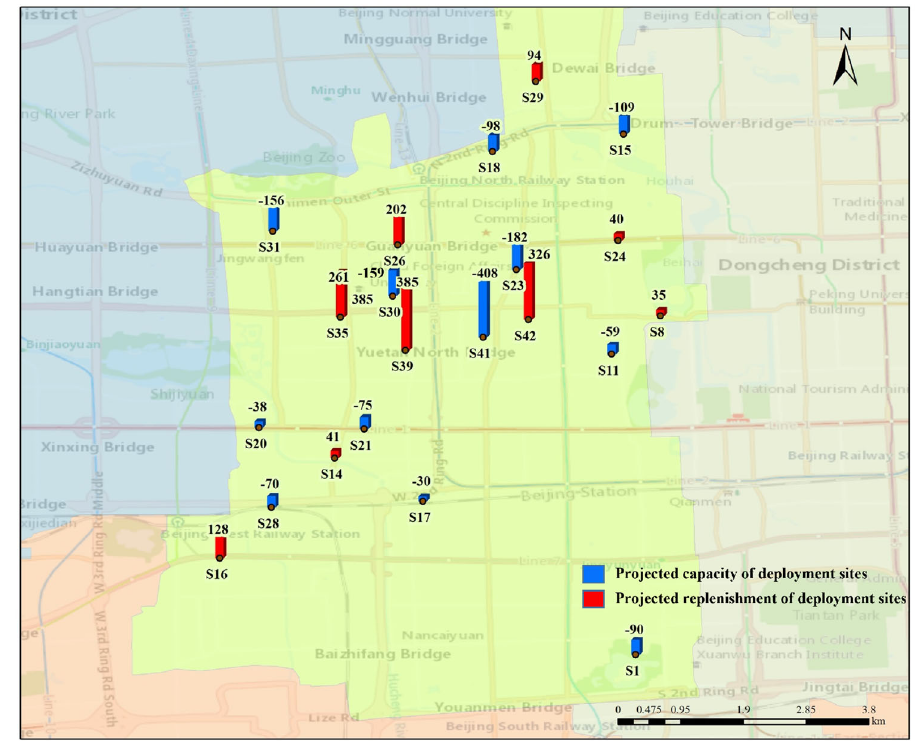
Fig. 7 Participating deployment sites and deployment volume